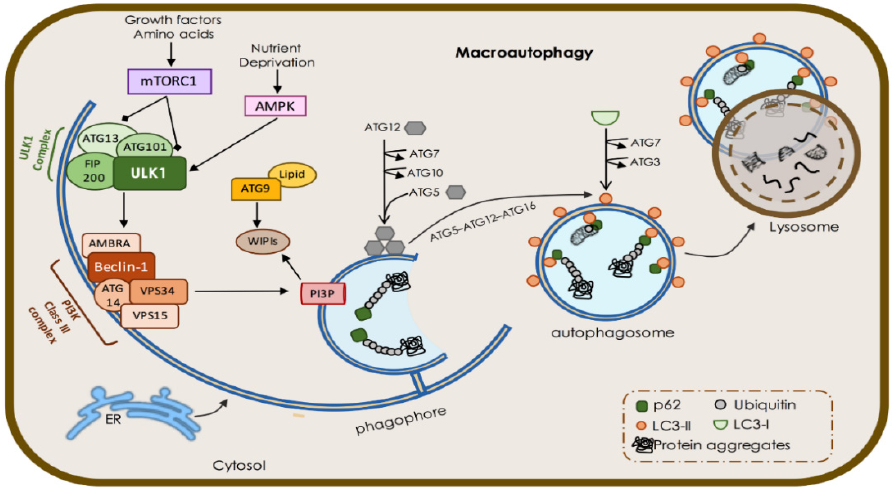
Figure 2. Overview of macroautophagy machinery. Nutrient deprivation and cellular stress induce mTORC1 inhibition and AMPK activation, which, in turn, activate the ULK1 complex. ULK1 complex positive regulation subsequently activates the phosphatidylinositol 3-kinase (PI3K) Class III complex, which leads to phagophore synthesis and initiates autophagy. The sources of membrane for phagophore nucleation and expansion can result from the ER membrane, Golgi apparatus, trans-Golgi network (TGN), plasma membrane, endosomal compartment, or mitochondria. Two ubiquitin-like conjugation systems, the Atg12–Atg5–Atg16L1 complex and LC3-II, participate in the expansion and closure of the phagophore. Once it is completed, the autophagosome can fuse with the lysosome to form the autolysosome, resulting in the degradation of autophagic